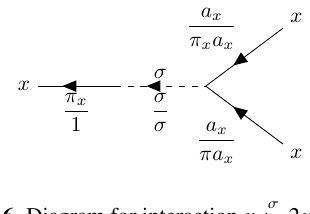
Figure 5. Diagram for interaction y